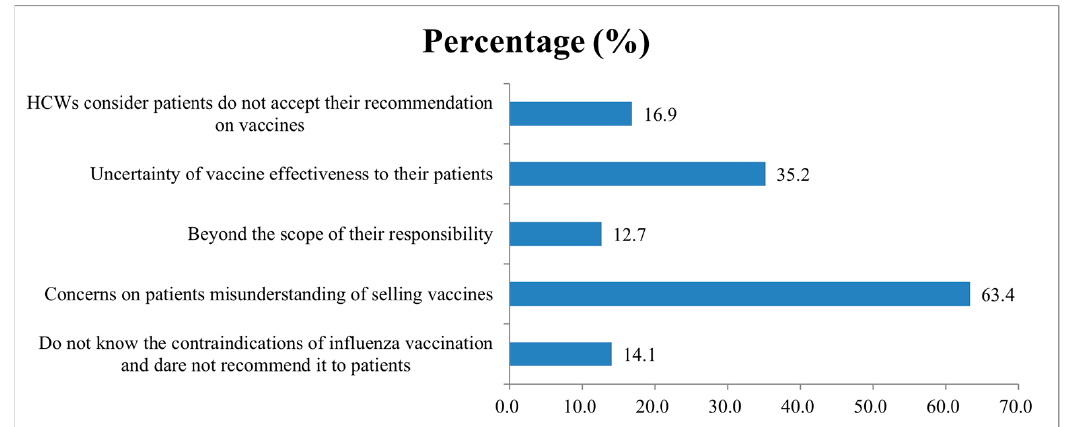
Figure 5. Reasons for not recommending the influenza vaccination to patients among community HCWs.